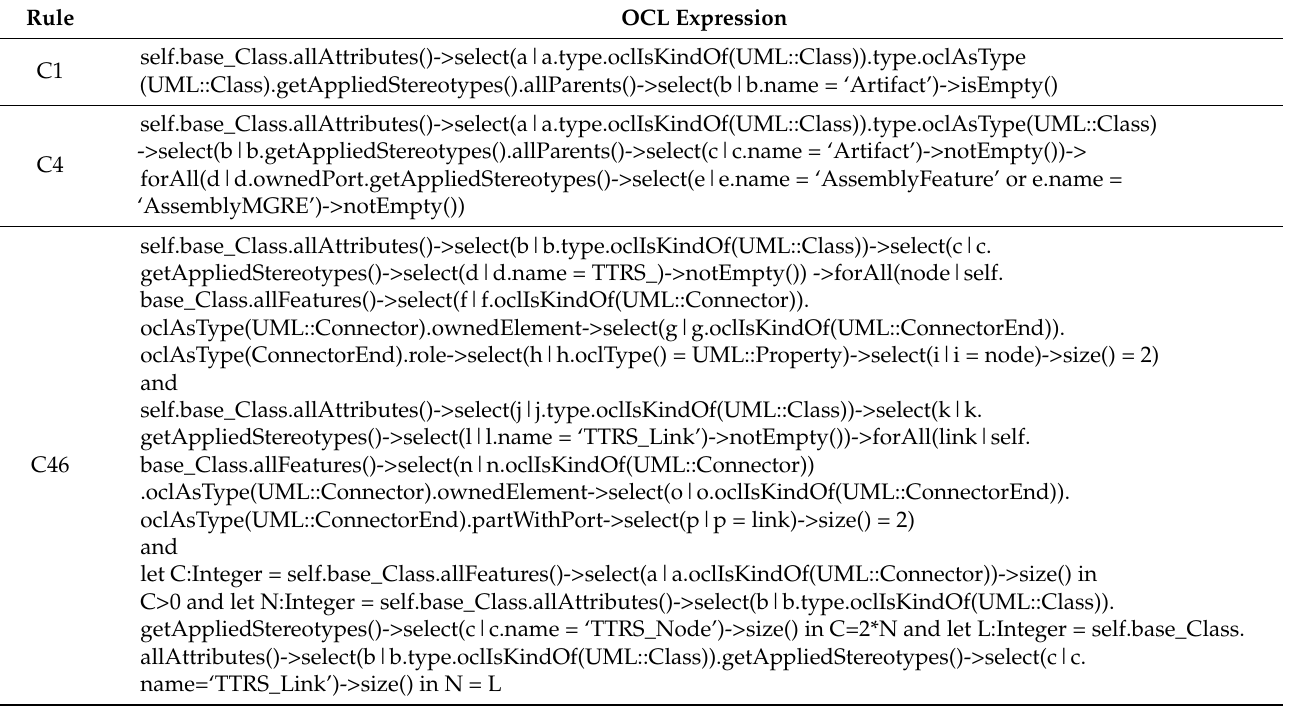
Table A5. OCL expressions corresponding to some described